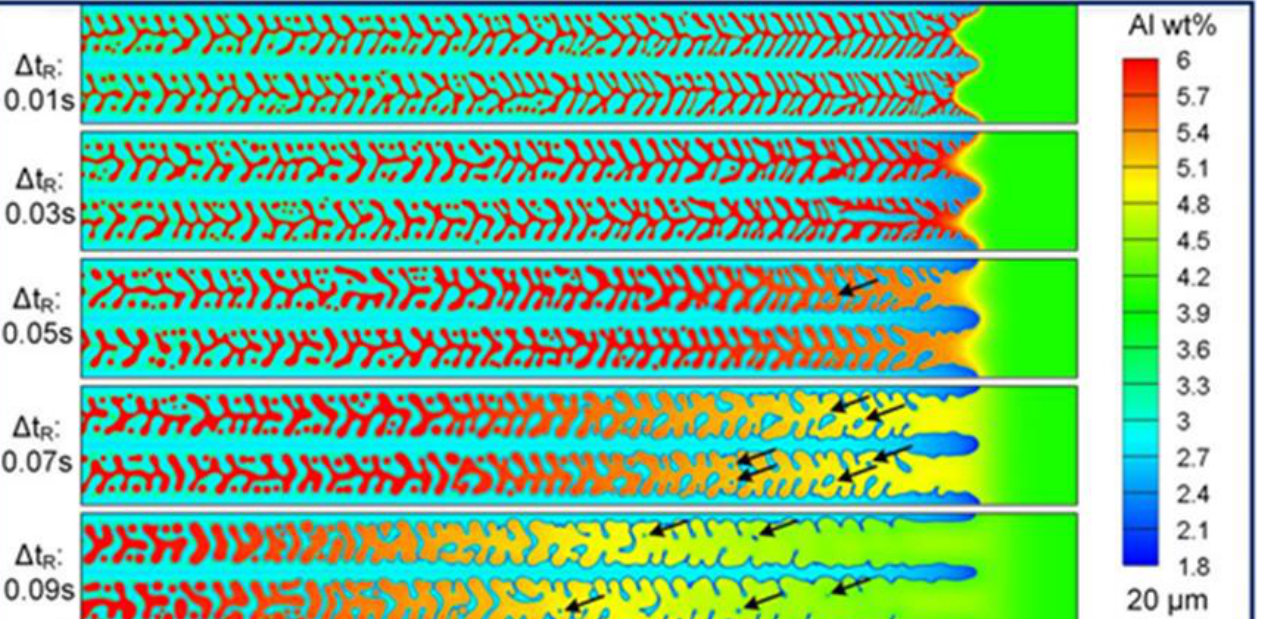
Figure 10. Effects of ∆ tR on the solidification morphologies during reheating, black arrows are markings for pinching-off and remelting